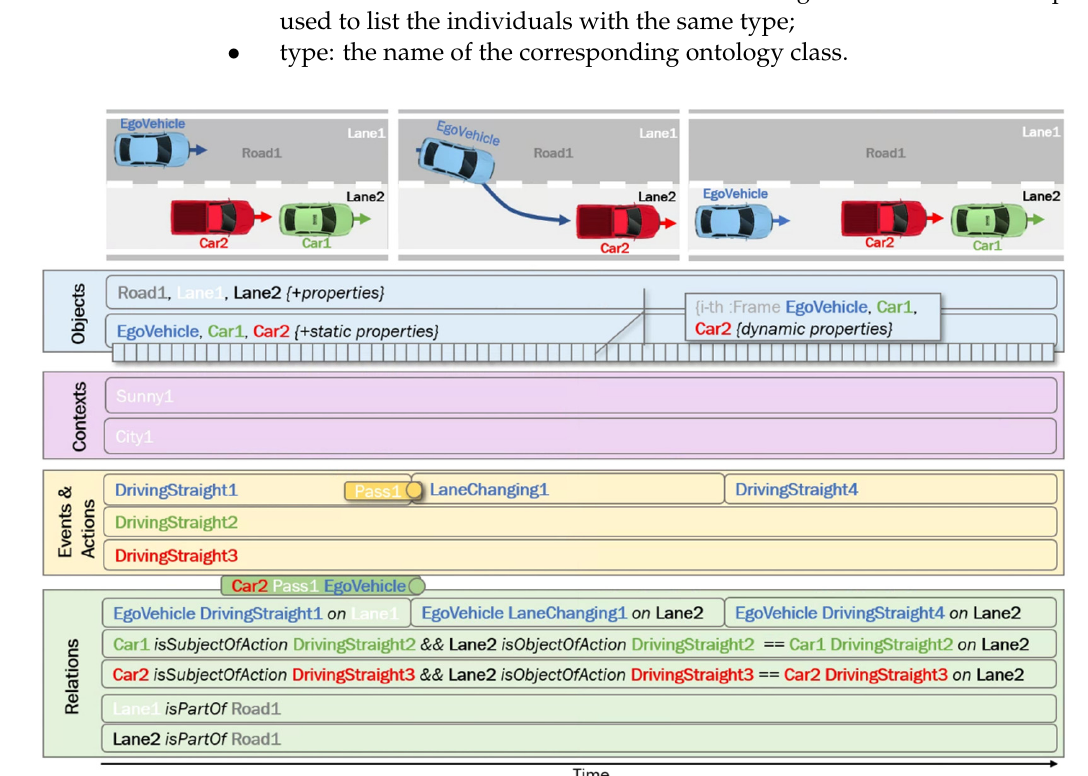
Figure 10. Diagram of the KITTI example scenario elements and relations illustrated over time.